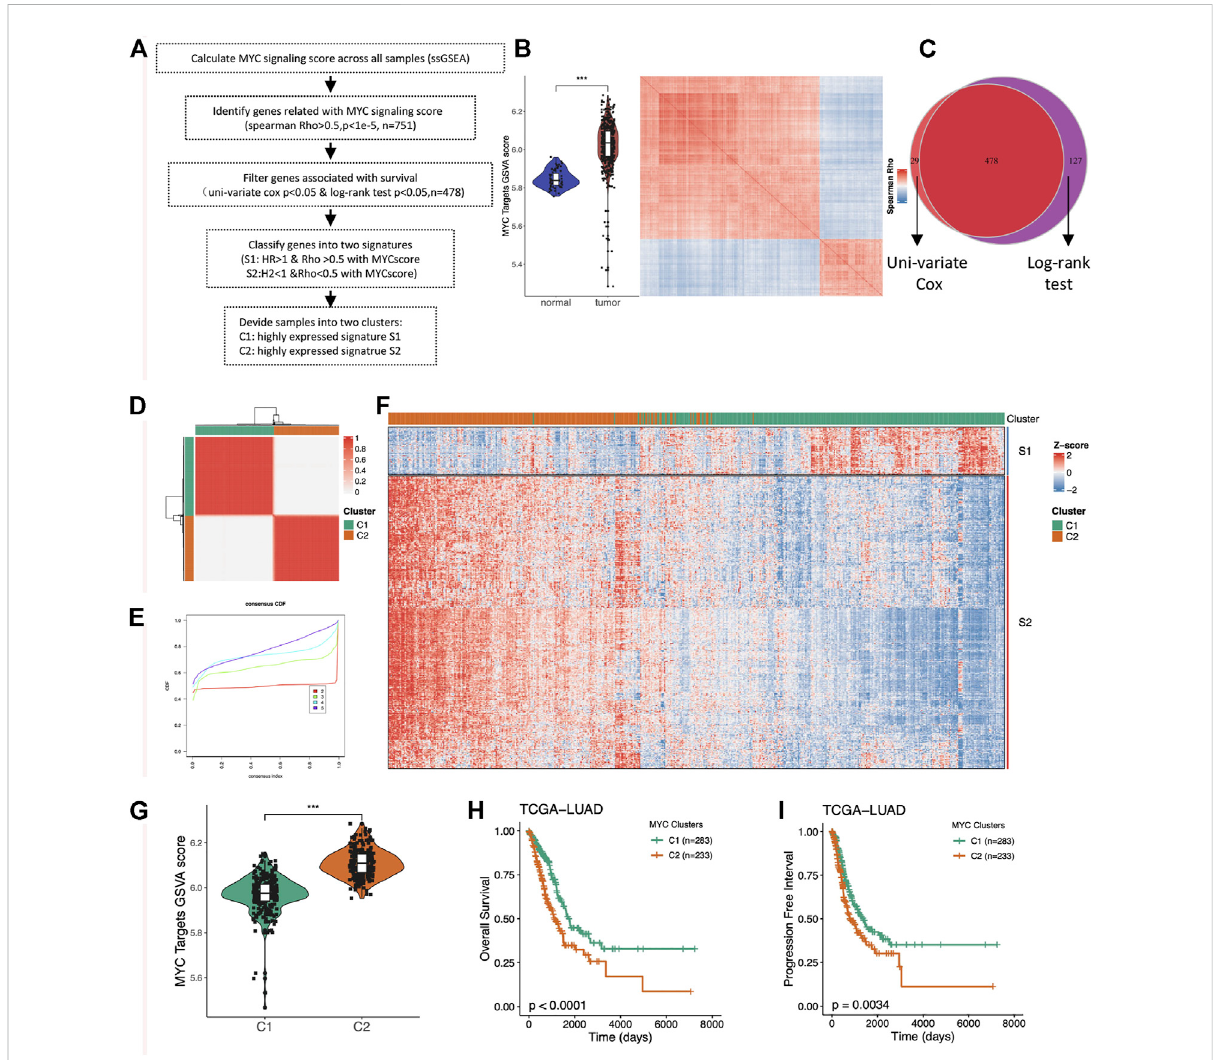
FIGURE 2 Identi fi cation of the two MYC signaling-associated signatures and unsupervised consistent clustering. (A) Flow chart of the sample classi fi cation. (B) Comparison of MYC Target GSVA scores between normal and tumor tissues in LUAD (right); Heatmap showing the hierarchical clustering of MYC Target GSVA scores-associated genes (left). (C) Venny plot showing survival-associated genes obtained by univariate cox analysis and log-rank test. (D) Unsupervised clustering divided the LUAD samples into two distinct subgroups (k = 2). (E) CDF and consensus index. (F) HeatmapshowingtheexpressiondistributionoftheSignaturegenesbetweenthetwoclusters. (G) ComparisonofMYCTargetGSVAscoresbetween the two distinct subgroups (C1 and C2). (H) Comparison of overall survival (OS) between C1 and C2. (I) Comparison of progress-free interval (PFI) between C1 and